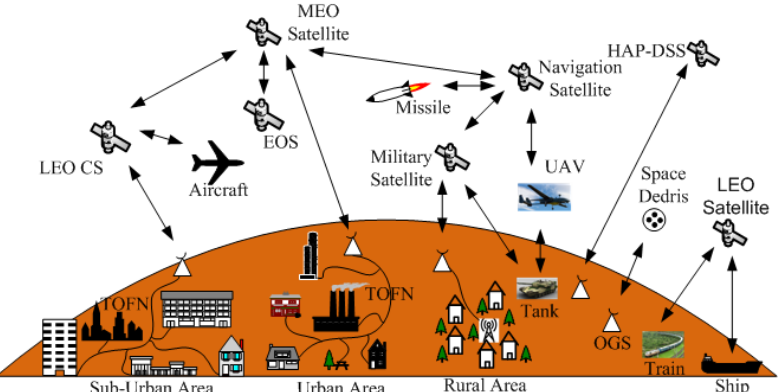
Figure 41. Next generation UOC network: terrestrial optical fiber network (TOFN), optical ground station (OGS), lower-earth-orbit control station (LEOCS), medium earth orbit (MEO), earth observation satellite (EOS), and HAP deep-space satellite.